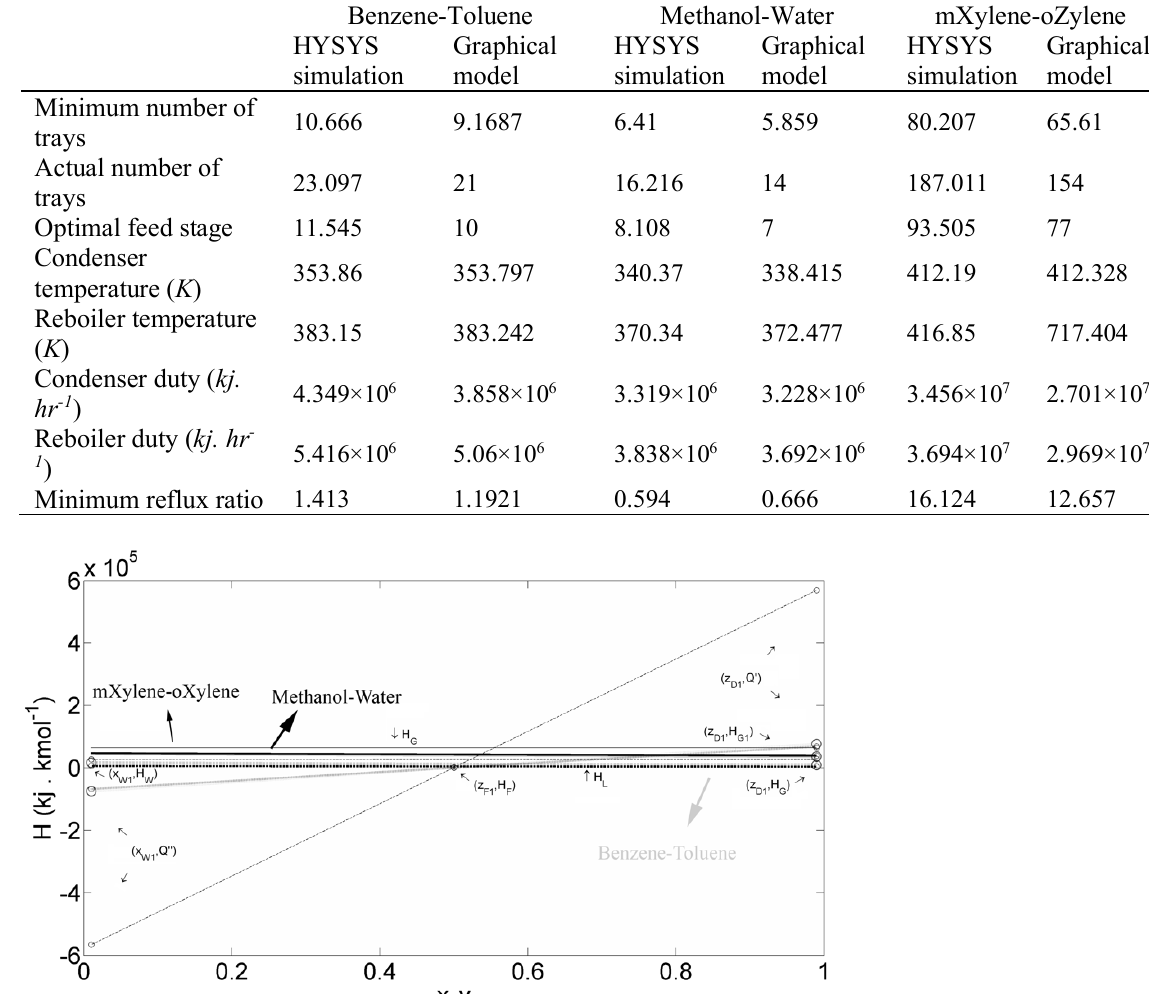
Figure 2. Enthalpy-Concentration diagram of solved graphical model for conditions of Table 2.